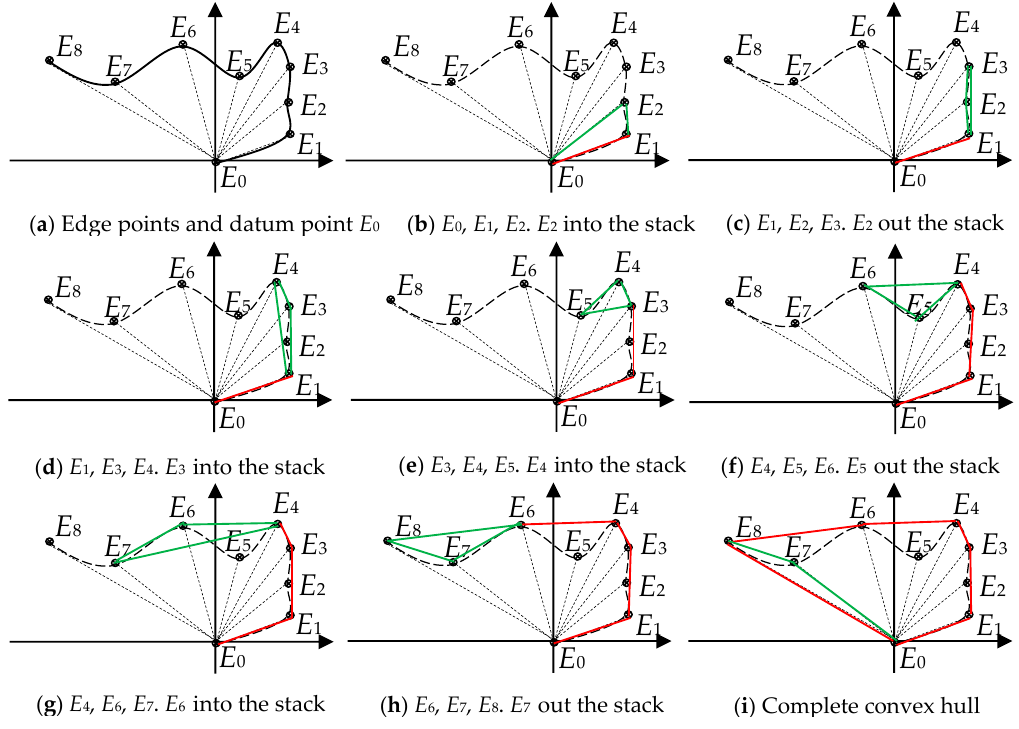
Figure 2. Schematic diagram of convex hull formation.